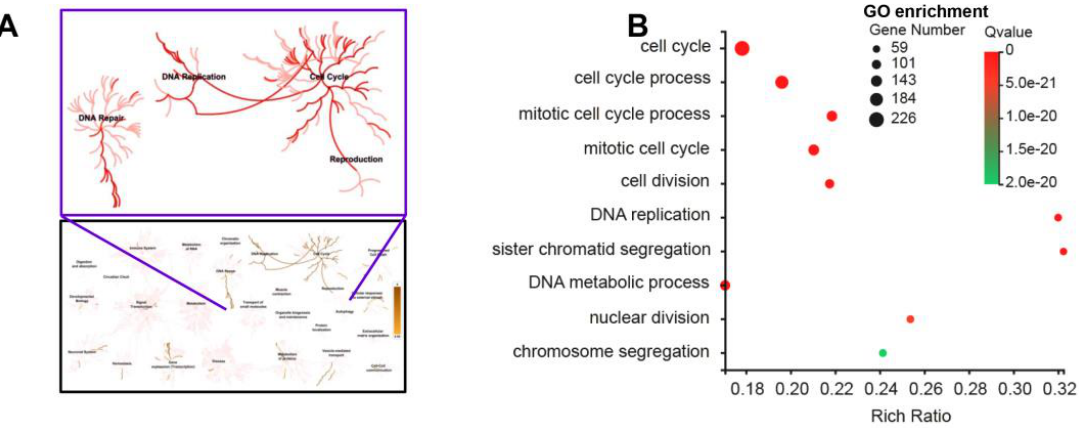
Figure 3. Figure 3. Cont .